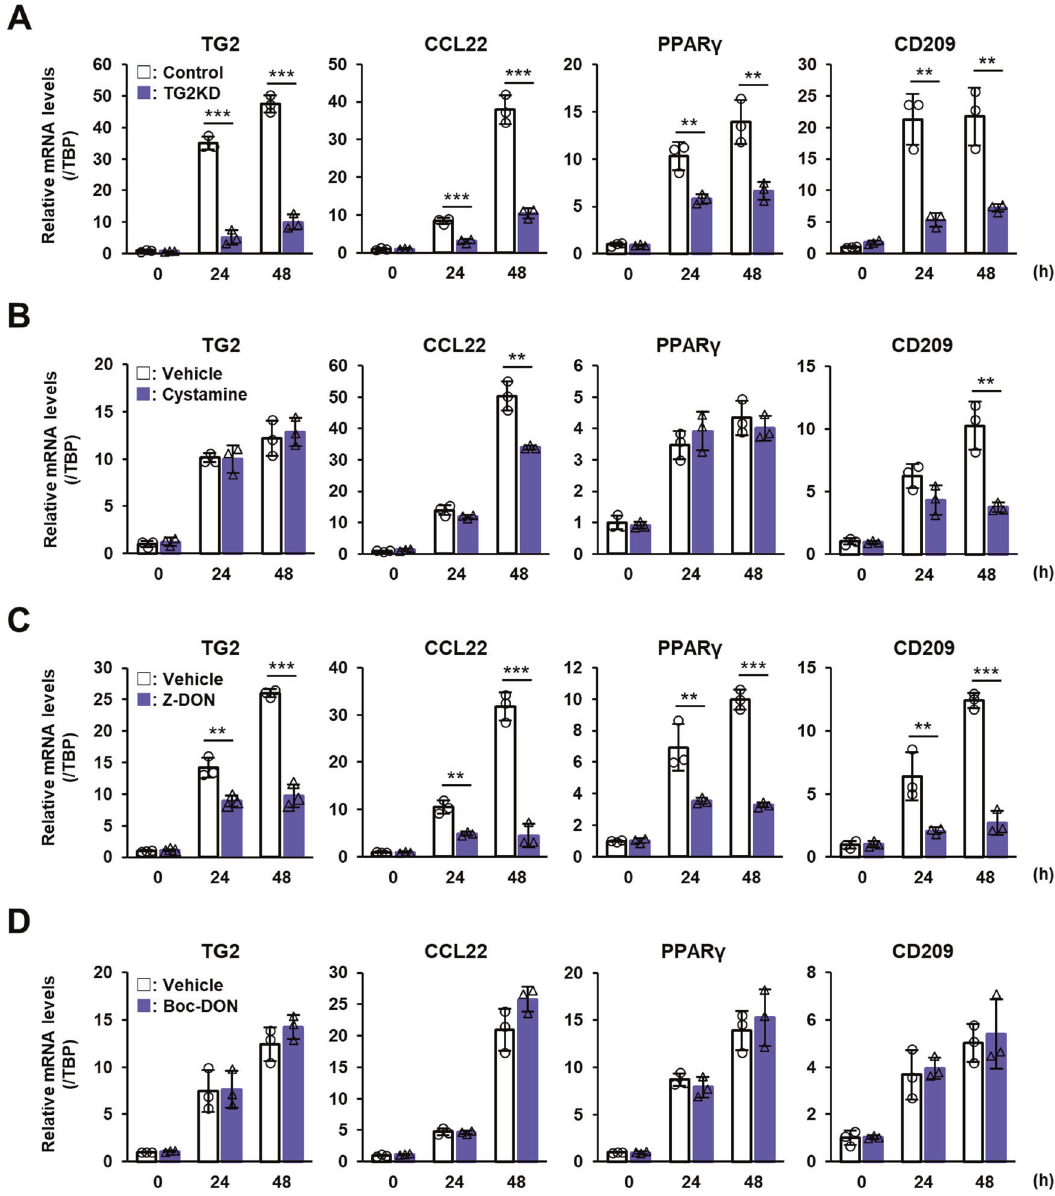
Fig. 6 Role of TG2 in human M2 macrophage polarization induced by IL-4. Human monocytic leukemia cell line, THP-1, was treated with 150 nM PMA for 24 h. M2 macrophage polarization was induced by 20 ng/ml recombinant human IL-4. mRNA expression levels of TG2 and indicated human M2 macrophage markers were analyzed. For knockdown experiment, PMA-treated macrophages were transfected with siRNA against TG2 ( A ). As a negative control, scrambled siRNA (Control) was replaced with the same amount of TG2 siRNA. For the TG2 inactivation, cell-permeable (0.4 mM Cystamine, B ; 50 μ M Z-DON, C ) and impermeable inhibitors (100 μ M Boc-DON; D ) were used. Data were normalized against mRNA expression of TBP and relative values were presented as the mean ± SD ( n = 3) (*** P < 0.001, ** P < 0.01, * P < 0.05, Student ’ s t regulator for human and mouse M2 macrophage polarization (Figs. 4 and 6, and Suppl. Fig. S4). Although TG2 extracellularly contributes to activation of TGF- β [26, 46 – 48], which is a major regulator for cell differentiation, it was interesting to note that only intracellular, but not extracellular, TG2 regulated M2 macrophage polarization. Active inhibitors targeting TG2 are expected to contribute to the development of useful drugs for the